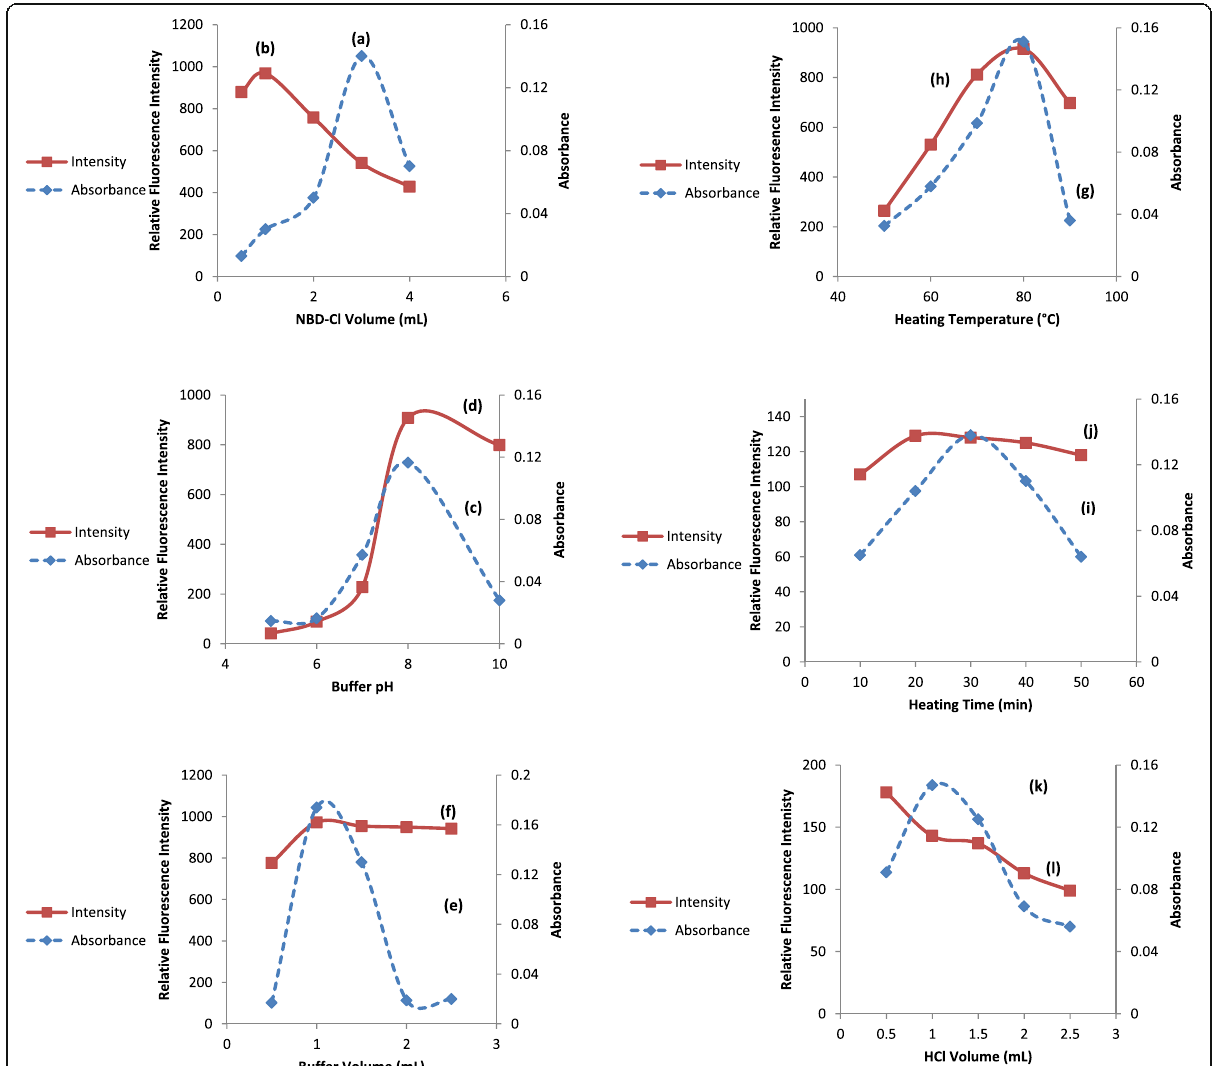
Fig. 6 Effect of NBD-Cl volume on absorbance a and on fluorescence intensity b of the reaction product. Effect of buffer pH on absorbance c and on fluorescence intensity d of the reaction product. Effect of buffer volume on absorbance e and fluorescence intensity f of the reaction product. Effect of heating temperature on absorbance g and fluorescence intensity h of the reaction product. Effect of heating time on absorbance i and fluorescence intensity j of the reaction product. Effect of HCl volume on absorbance k and fluorescence intensity l of the reaction product. For absorbance measurements, 50 μ g/mL of VP was used with 0.2% w/v NBD-Cl and for fluorescence intensity measurements, 10 μ g/mL of VP was used with